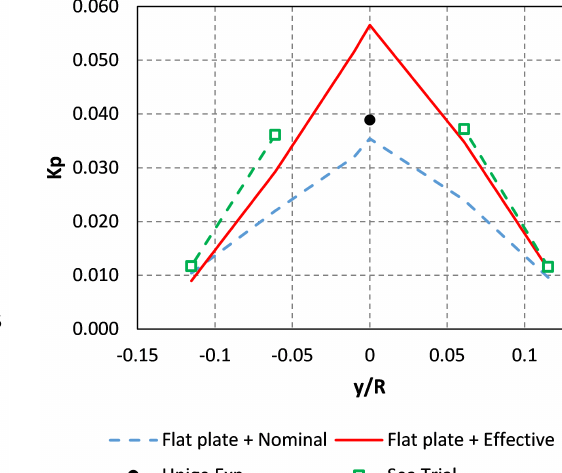
Figure 14: First harmonic values in correspondence to different transversal points at longitudinal propeller plane position. Effect of the hull shape and of nominal and effective wakes.